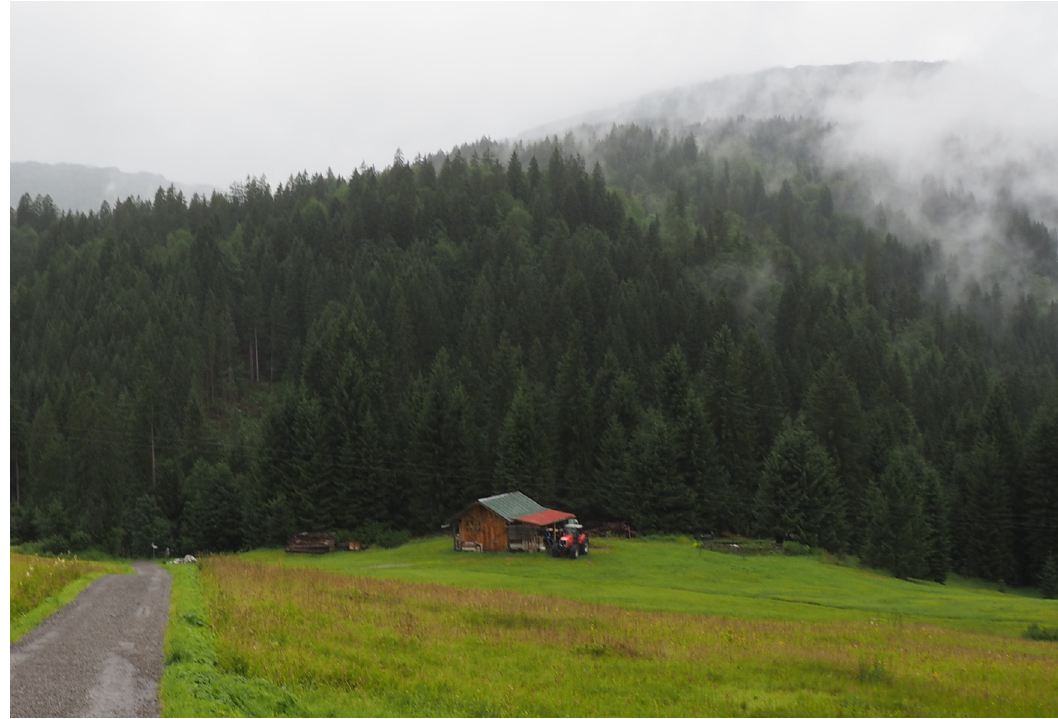
Figure 3: Open - air site Egg - Schwarzwasser , seen from the south -